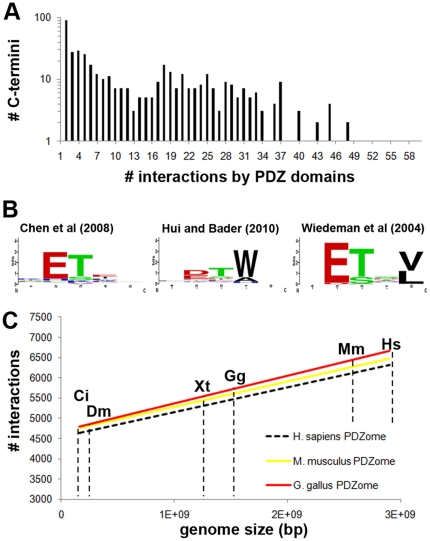
Extensive binding overlap within the PDZome.(A) Implementing a Bayesian model for PDZ domain binding prediction, we used 254 PDZ domain binding pockets (96% coverage of the human PDZome) identified to predict the number of PDZ domain interactions with 22,997 human C-termini that were derived from Ensembl longest transcript sequences. The mean ± s.e.m number of PDZ ligands per domain was 24±3.7, which strongly suggested that the PDZ domain binding pockets are not inherently optimized to minimize cross-selectivity within the human cell. (B) Comparison between PMWs computed using the human C-termini and the binding pockets of Erbin using the predictive models of Chen et al [17], Hui and Bader [30], and Wiedeman et al [47], for which we used a cut-off of Kd<100 µM. (C) Using the PDZ binding pockets identified for other vertebrates in this study, we also found extensive overlap in these species. Cross-comparison of the binding capabilities using six sets of C-termini (proteomes used are marked by dashed lines and a two letter species abbreviation) reveals that for the three vertebrate PDZomes investigated no significant differences were observed as assessed by student t-test (P>0.8). All numbers were normalized to the Homo sapiens PDZome.